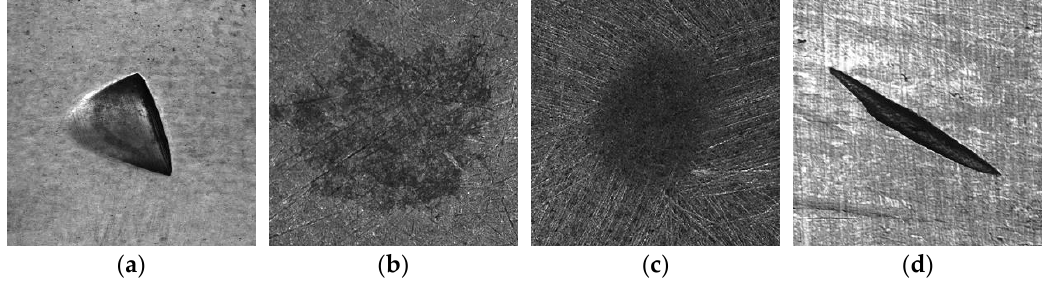
Figure 4. Details of common defect categories: ( a ) Damage; ( b ) corrosion; ( c ) grind lacking; and ( d ) scratch .